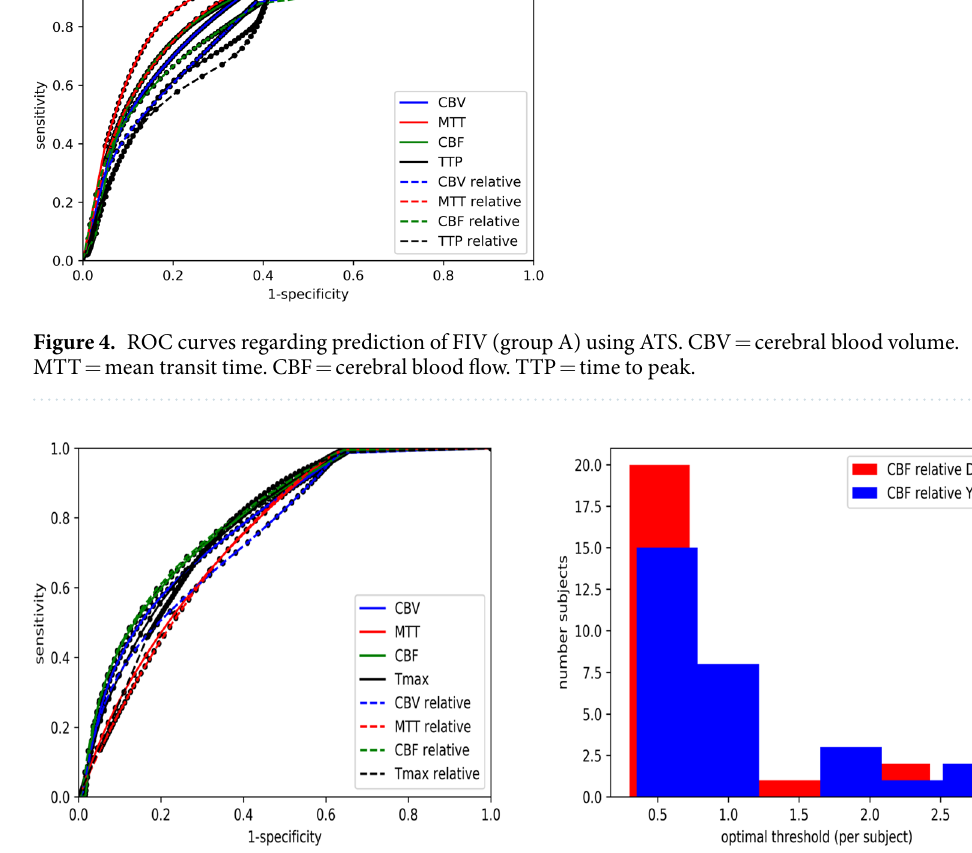
Figure 5. On the left hand side, ROC curves regarding prediction of FIV (group B) using ATI. On the right hand side, optimal threshold distribution per subject regarding CBF_rel of ATI using Dice’s coefficient and Youden-Index. CBV = cerebral blood volume. MTT = mean transit time. CBF = cerebral blood flow. Tmax = time to the maximum of the residue function obtained by deconvolution.